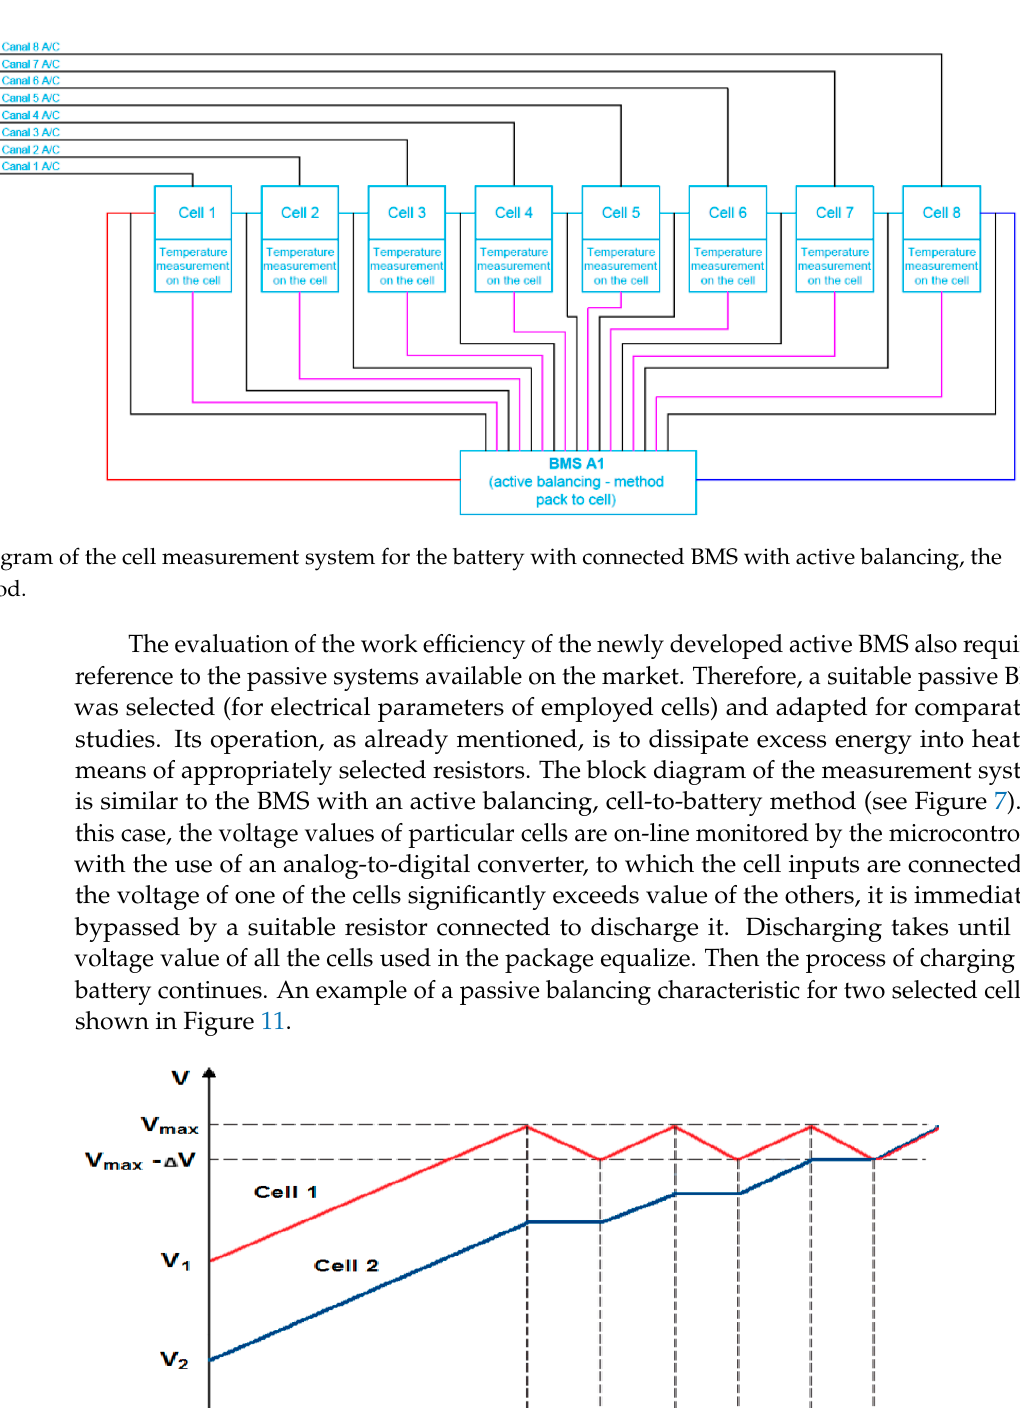
Figure 11. An example of the characteristics of passive balancing (cell 1—overcharged, cell 2—undercharged; t 1 –t 2 , t 3 –t 4 , t 5 –t 6 —duration of following discharge/charge).